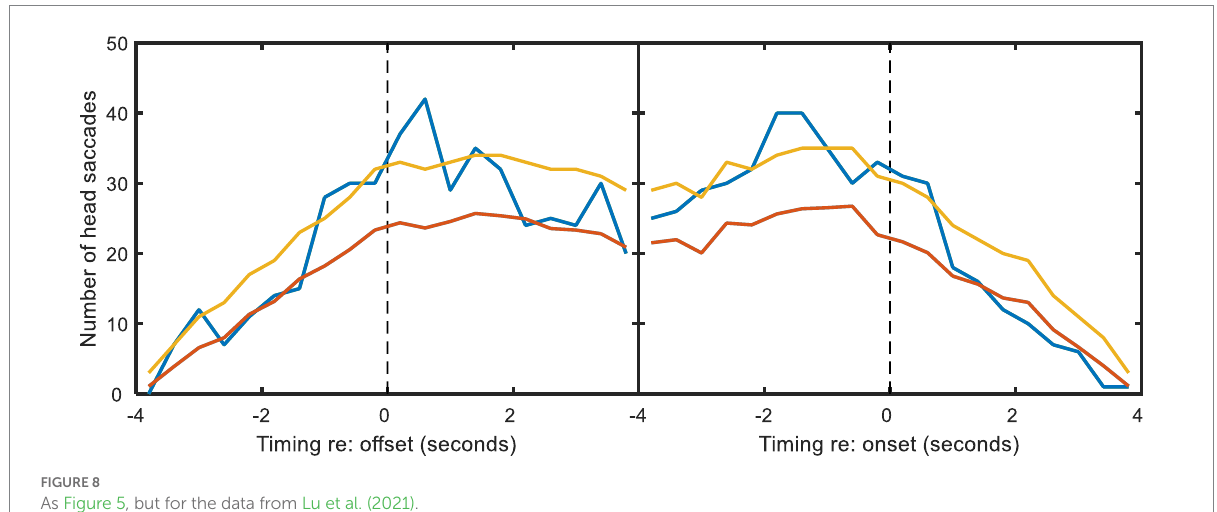
FIGURE 8 As Figure 5, but for the data from Lu et al.